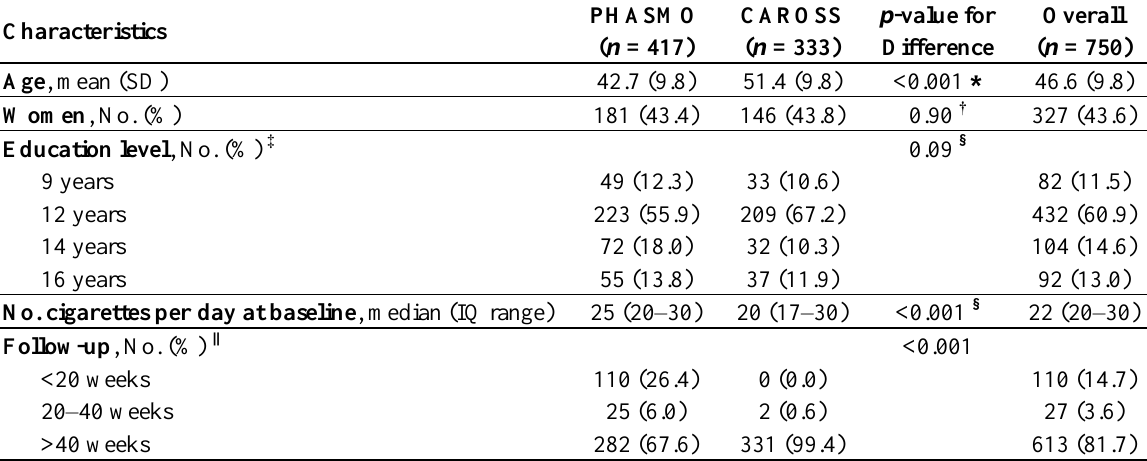
Table 1. Individual